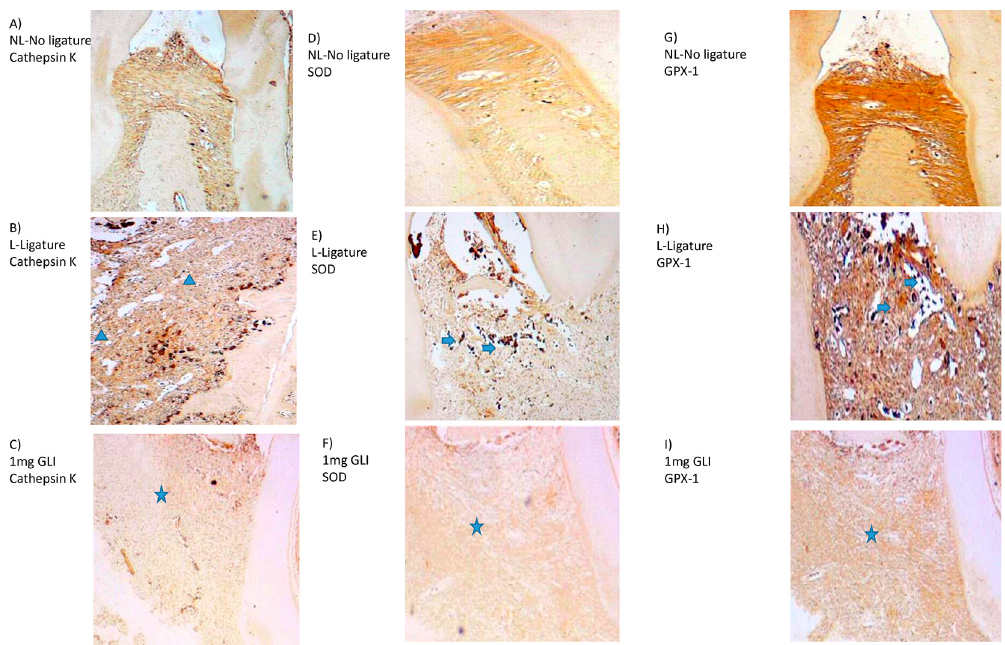
Figure 5- Photomicrographs of maxillary periodontal tissue from rats with periodontal disease treated with 1 mg/kg gliclazide (GLI) and control groups (no ligature and ligature), showing immunoreactivity to cathepsin (CAT), superoxide dismutase-1 (SOD-1) and glutathione peroxidase-1 (GPx-1). (A, D, G) Rats with no ligature. (B, E, H) Rats with ligature. (C, F, I) Rats with ligature treated with 1 mg/kg GLI. Arrow indicates high or moderate labeling in the periodontal ligament or alveolar bone. Asterisk indicates mild labeling in the periodontal ligament or alveolar bone. Triangle indicates intense labeling in alveolar bone. Images are shown at 40× magnification